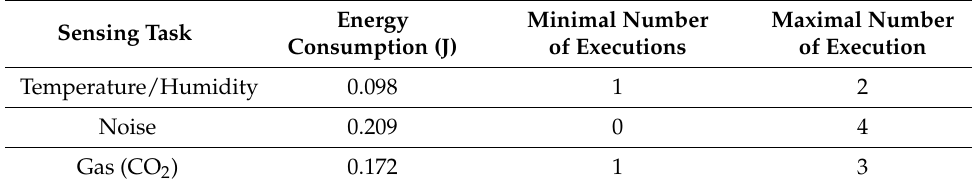
Table 4. Characteristics of the tasks executed by the multi-task energy harvesting